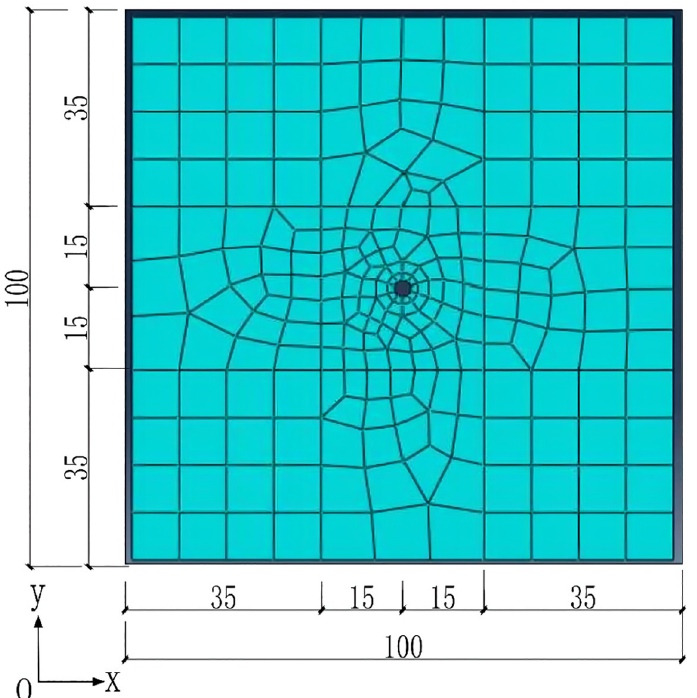
Fig 5. Grid division of the simulation area.